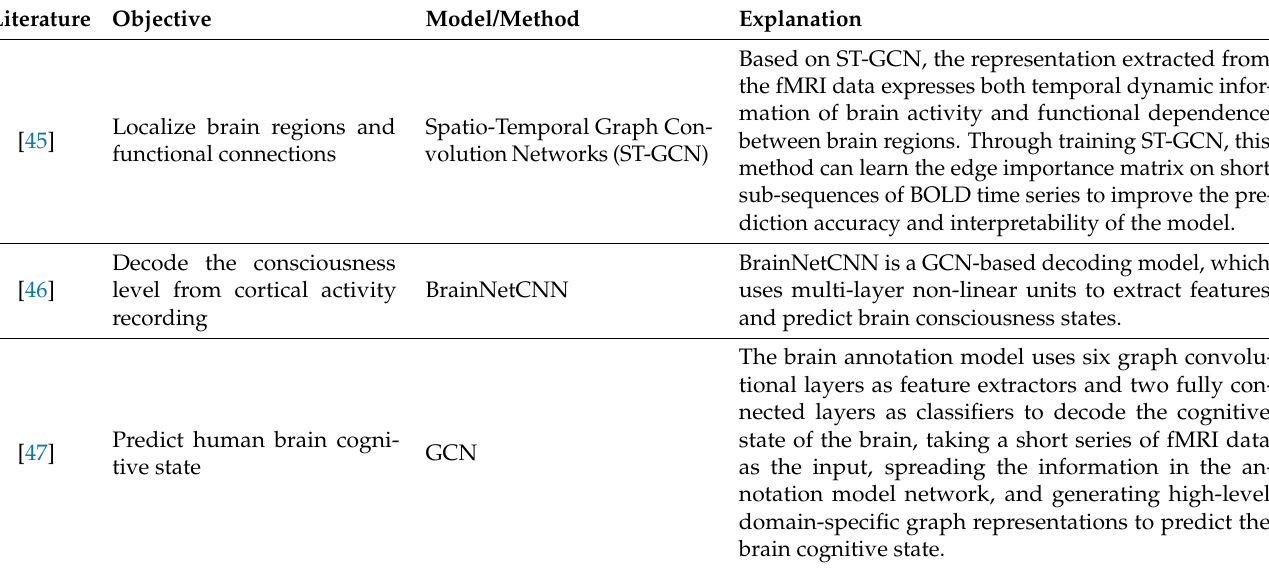
Table 4. GCN-based brain